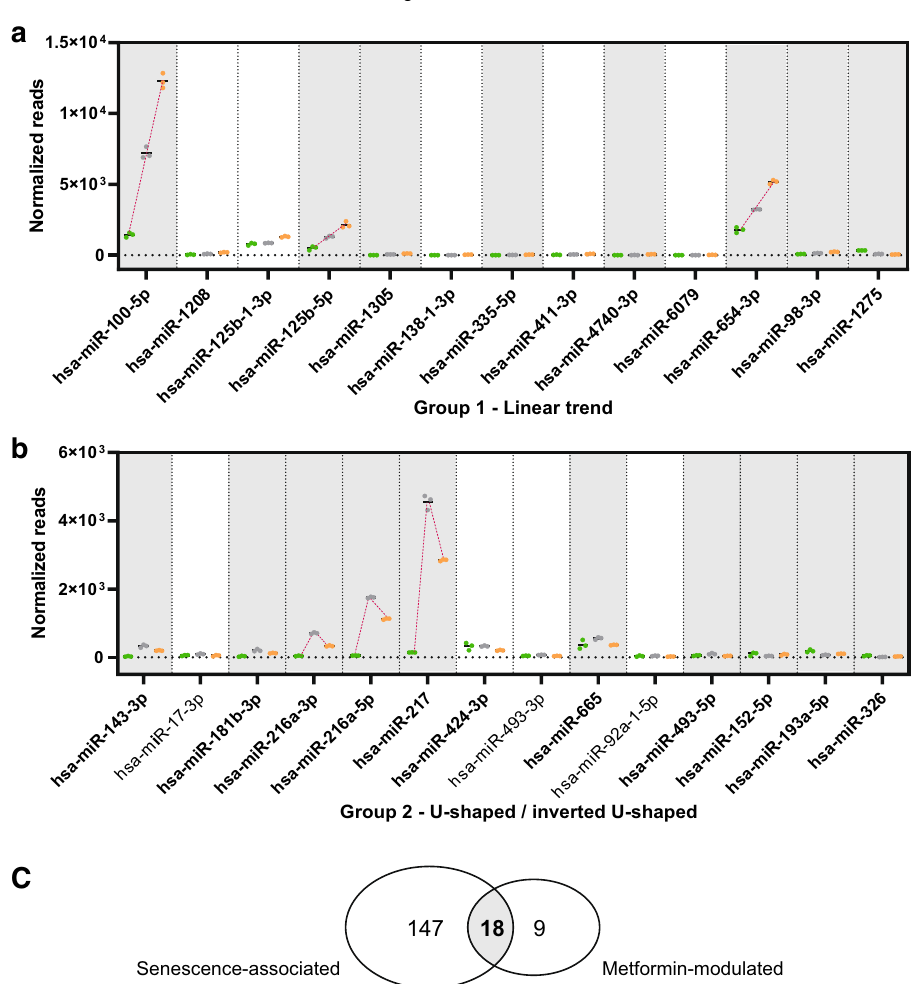
Figure 5. Influence of metformin treatment on senescence-associated miRNA modulation. Normalized reads of 27 miRNAs differentially modulated in Young (green), SEN (gray), and SEN + M (orange), grouped according to the linear ( a ) or U-shaped/inverted U-shaped ( b ) pattern of modulation. MiRNAs with a significant likelihood-ratio test are highlighted in bold. Senescence-associated miRNAs are highlighted with a gray background. ( c ) Venn diagram reporting the number of miRNAs differentially regulated in SEN compared to Young cells and in SEN + M compared to